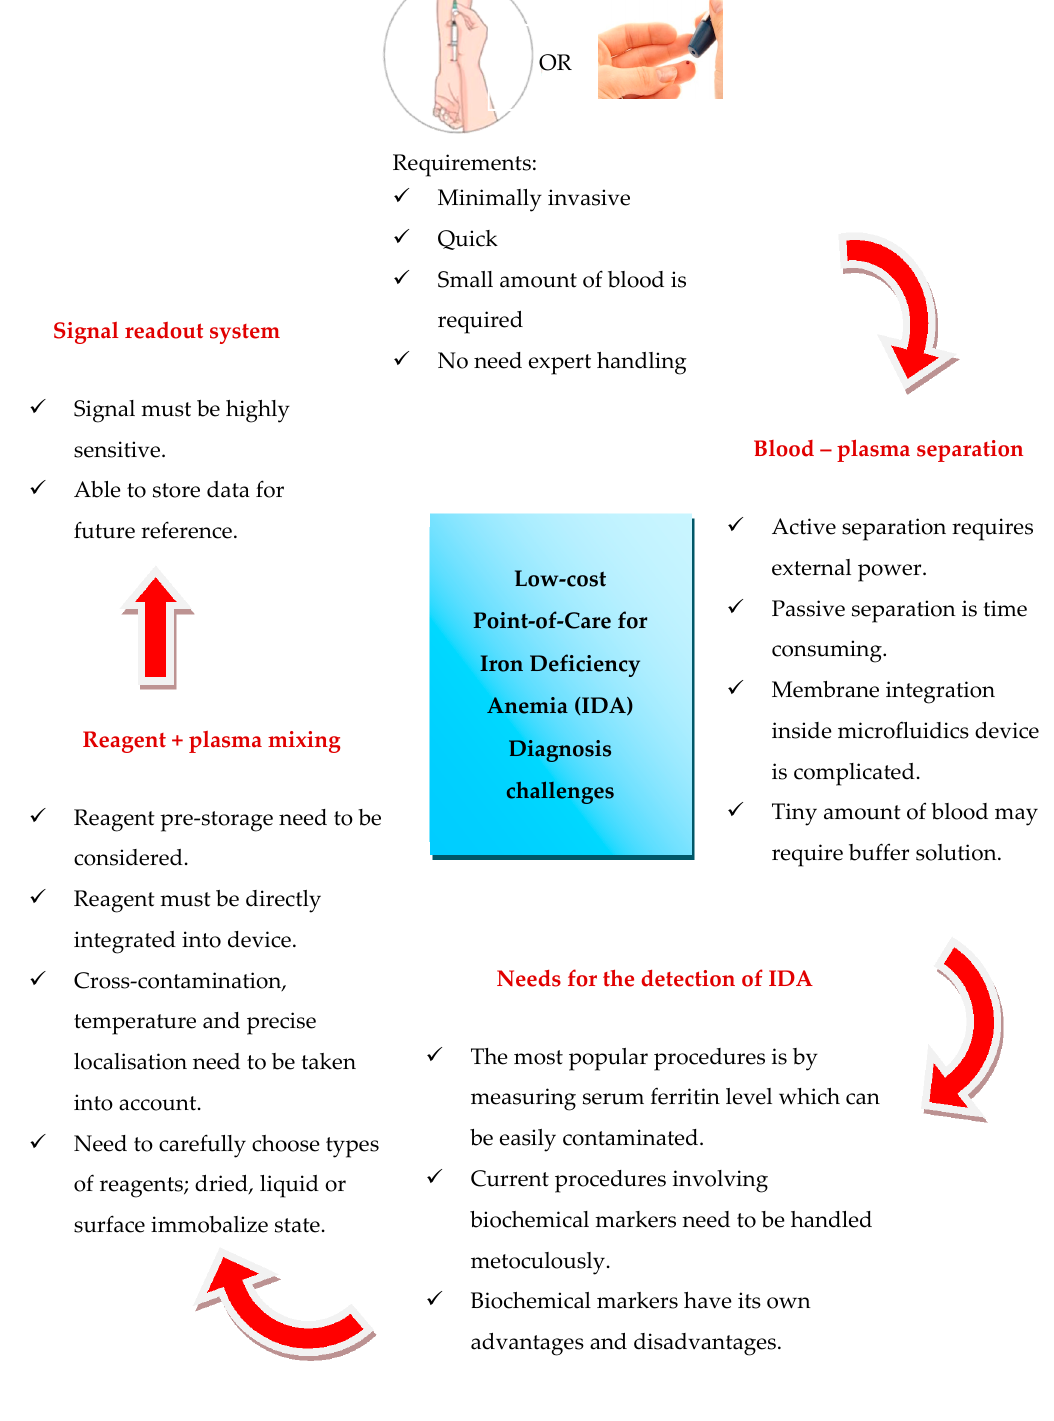
Figure 6. Challenges for developing an all-in-one portable iron deficiency anemia Figure 8. Challenges for developing an all-in-one portable iron deficiency anemia (IDA).